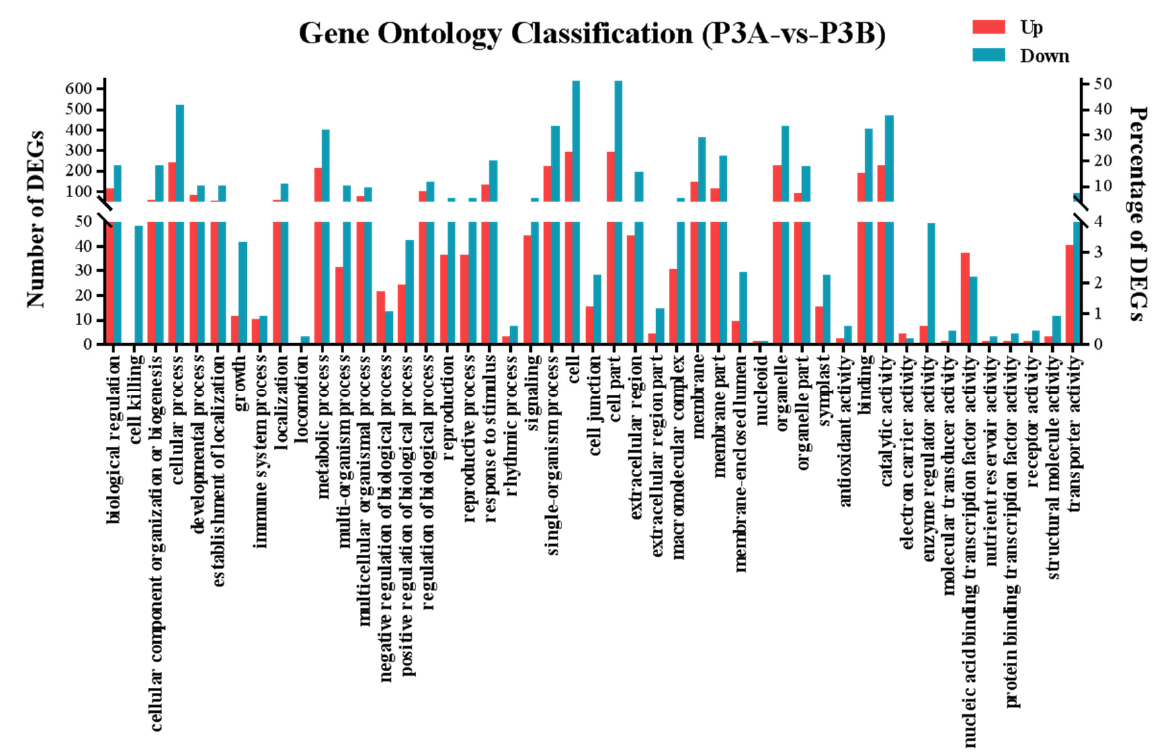
Figure 6. GO enrichment analysis of differentially expressed genes (DEGs).